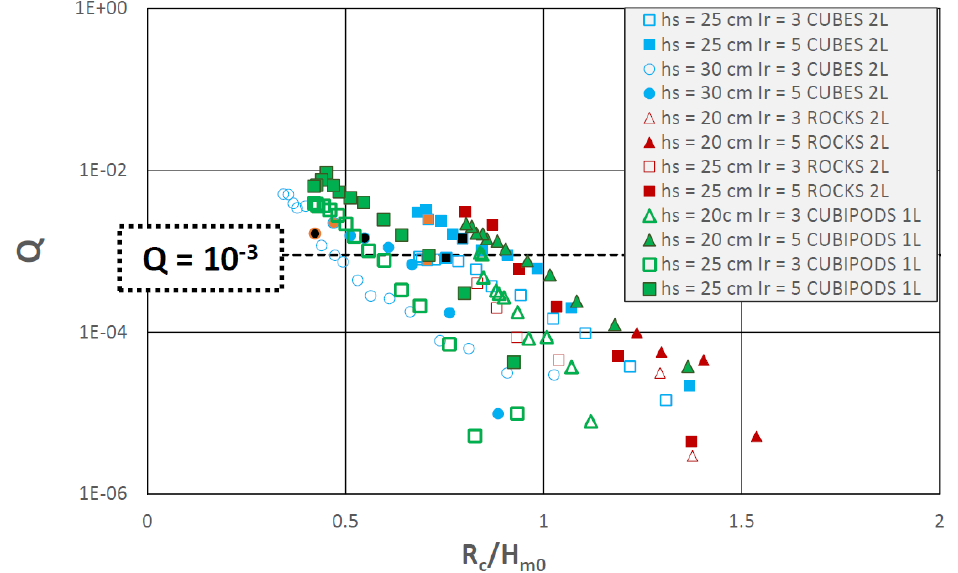
Figure 12. Measured overtopping discharge in terms of normalized freeboard (cube, rock, and Cubipod ® armors).